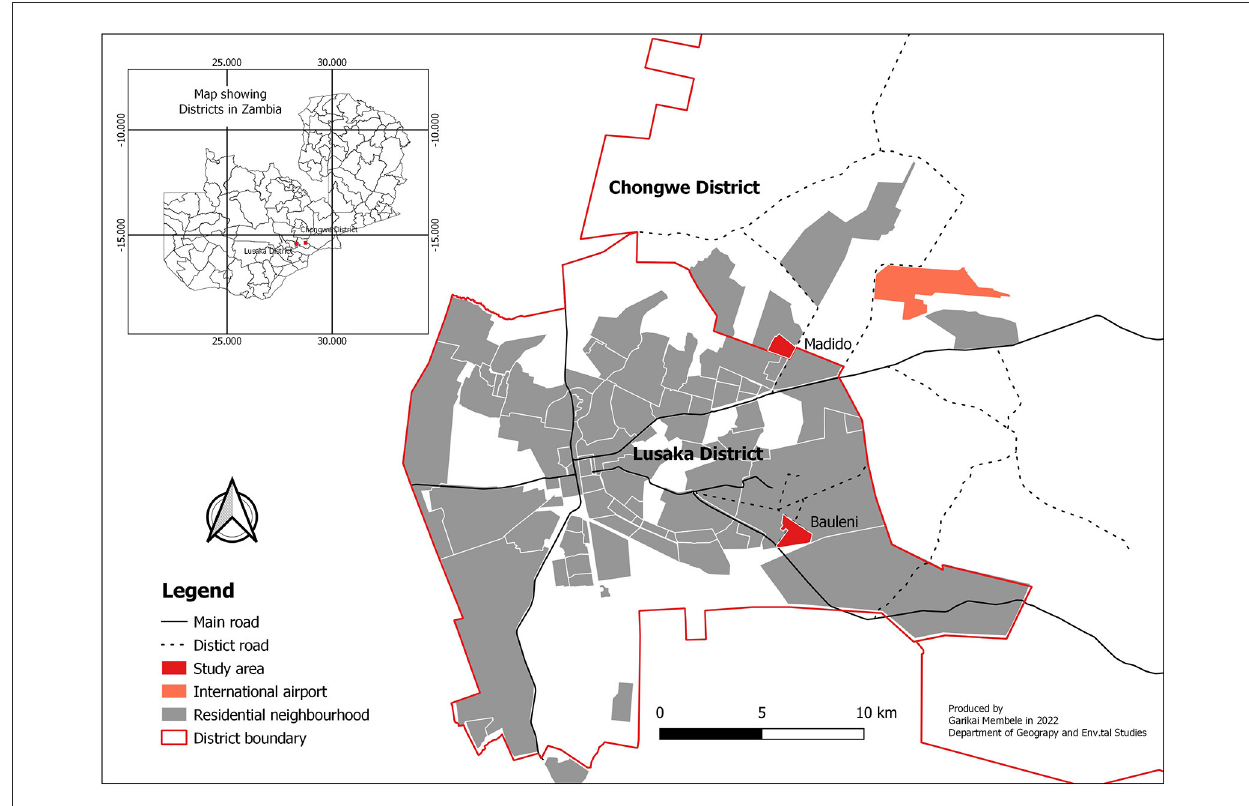
FIGURE2 Location of Bauleni and Madido in Lusaka City region,